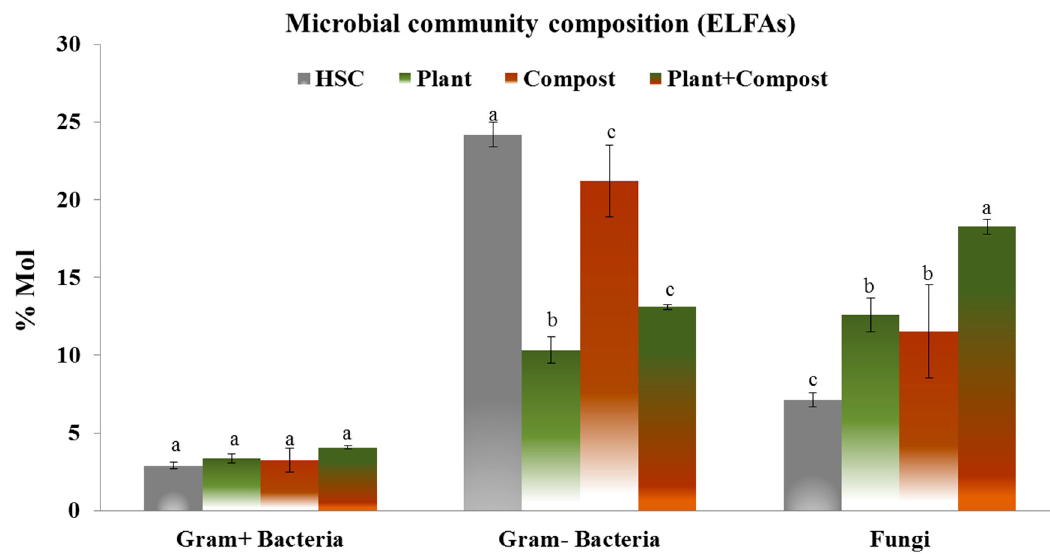
Figure 6. Microbial community structure assessed by ester-linked fatty acids (ELFA) expressed as % Mol at day 224 in the different treatments. HCS: historically contaminated soil; Compost: historically contaminated soil amended with municipal solid waste compost; Plant: historically contaminated soil with Medicago sativa plant; Compost + Plant: historically contaminated soil amended with the compost, in the presence of Medicago sativa plant. The vertical bars represent the standard errors. Lowercase letters indicate significant differences (p < 0.05) among treatments within the same microbial group.